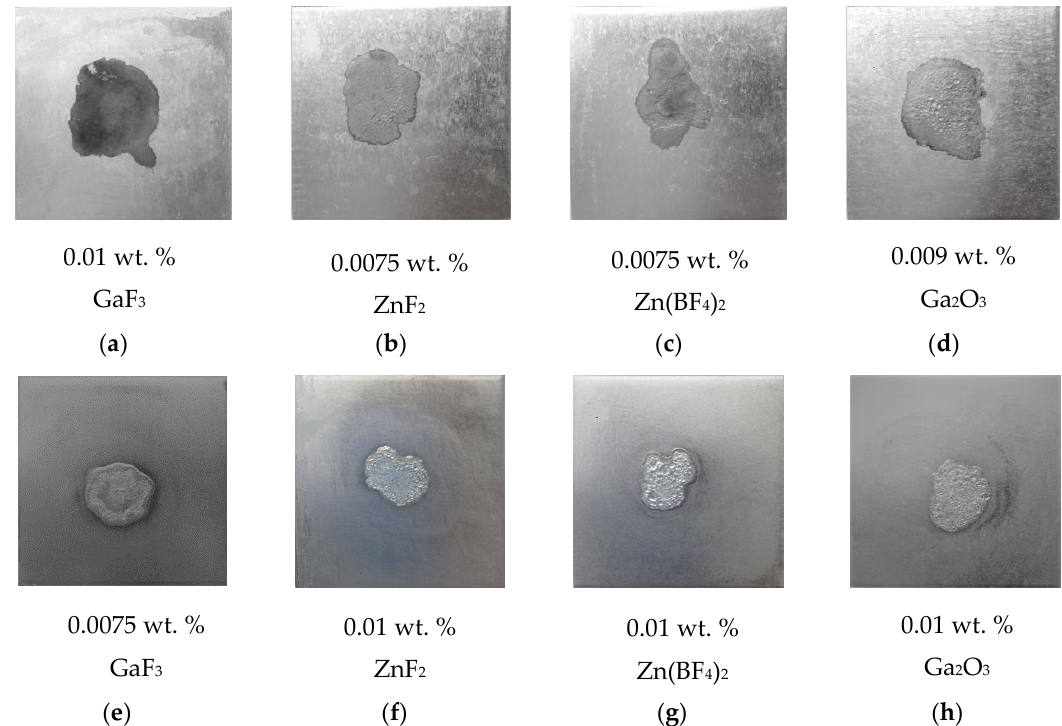
Figure 4. Spreading boards of Zn-15Al filler metal on base metals with CsF-RbF-AlF 3 flux doped with different additions: ( a – d ) 6061 aluminum; ( e – h ) Q235 low-carbon steel.